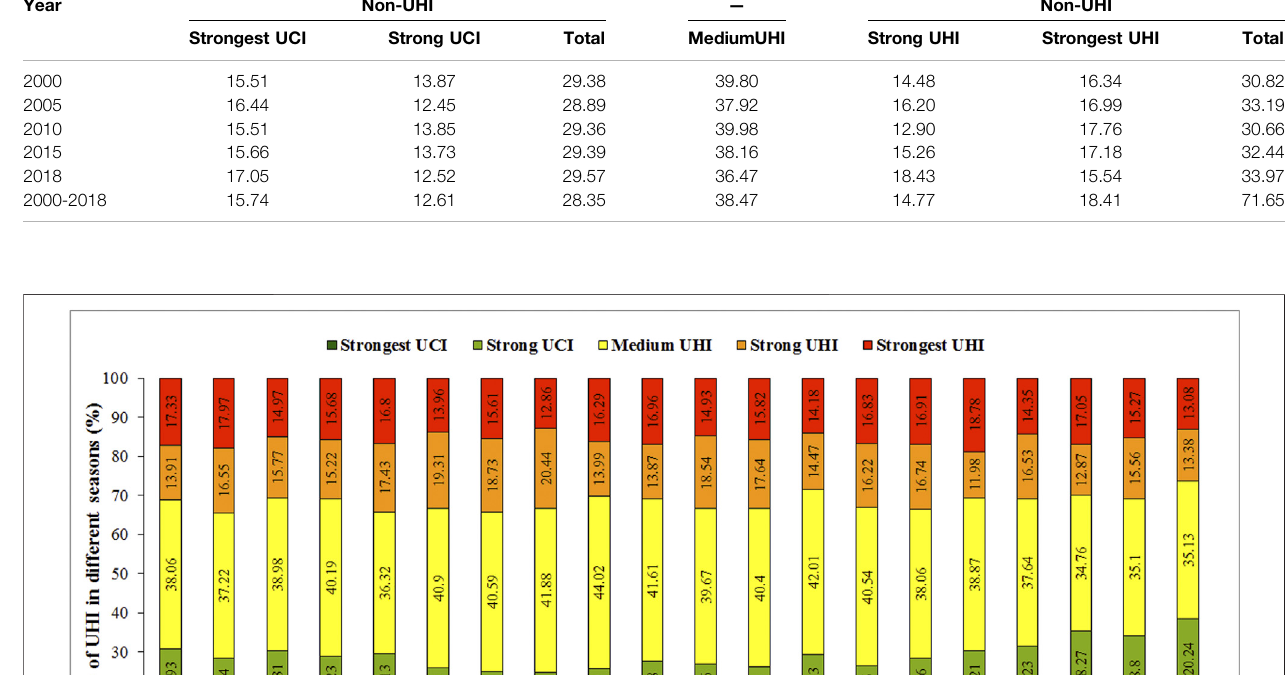
TABLE 2 | Area ratios of fi ve levels of the UHI effect during the period 2000-2018 (unit: %). Year Non-UHI — Non-UHI Strongest UCI Strong UCI Total MediumUHI Strong UHI Strongest UHI Total